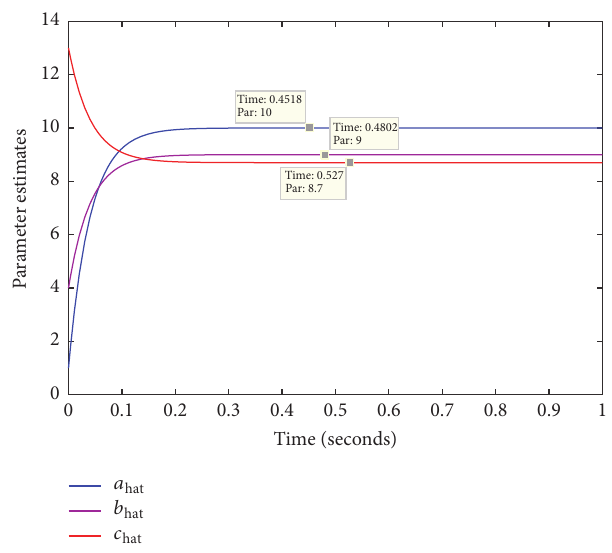
Figure 9: Estimated Parameters ( 𝑎,𝑏, 𝑐